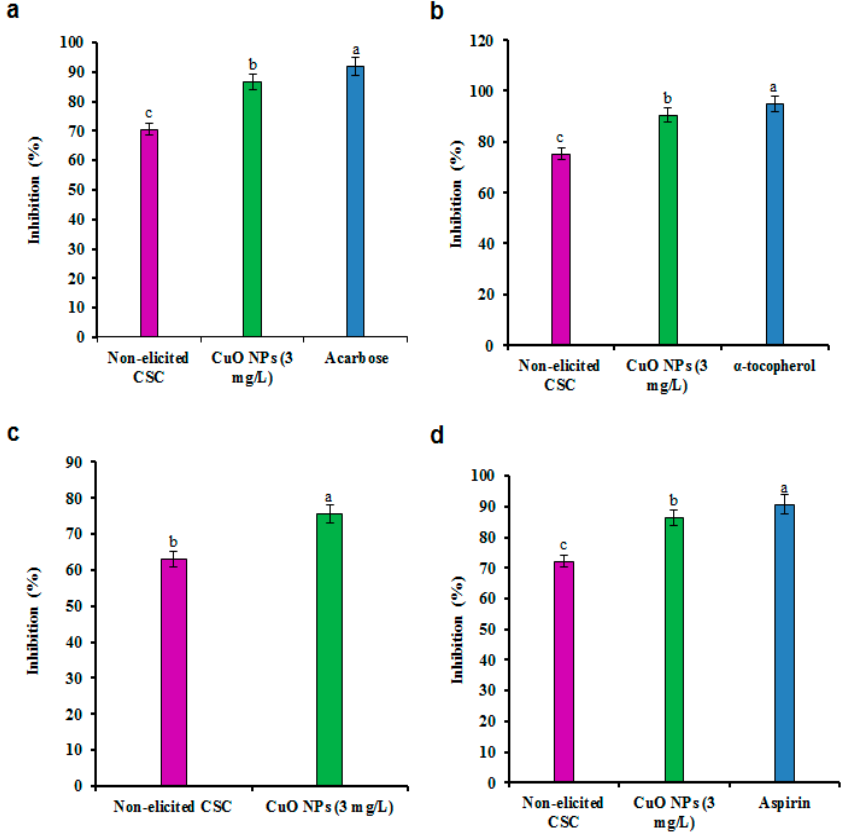
Figure 5. Effect of CuO NPs on antidiabetic and anti ‐ inflammatory activities in CSC of G. sylvestre. ( a ) In vitro α -amylase activity, ( b ) non-enzymatic glycosylation of hemoglobin activity, ( c ) lipoxygenase ( a ) In vitro α‐ amylase activity, ( b ) non ‐ enzymatic glycosylation of hemoglobin activity, ( c ) inhibition activity, ( d ) albumin denaturation inhibition assay. Di ff erent letters indicate a significant lipoxygenase inhibition activity, ( d ) albumin denaturation inhibition assay. Different letters indicate a significant difference at p ≤ 0.05. di ff erence at p ≤